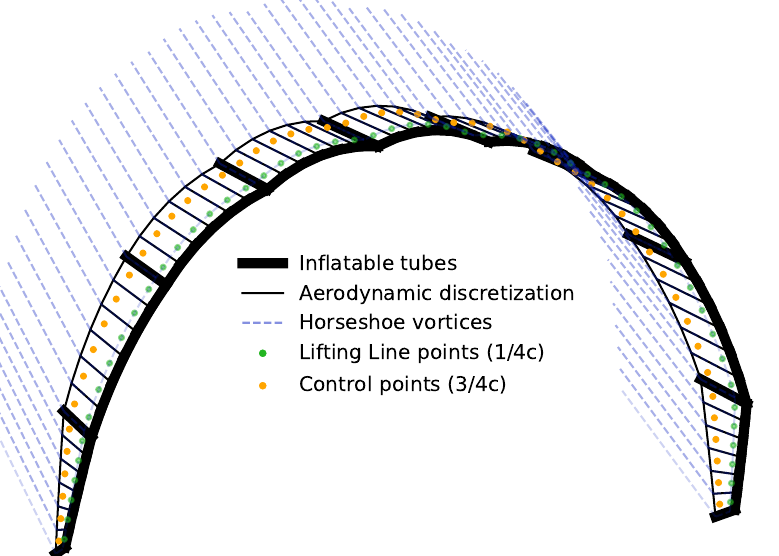
Figure 5. Aerodynamic model of the LEI V3 kite, illustrated for a coarse spanwise discretization of the wing